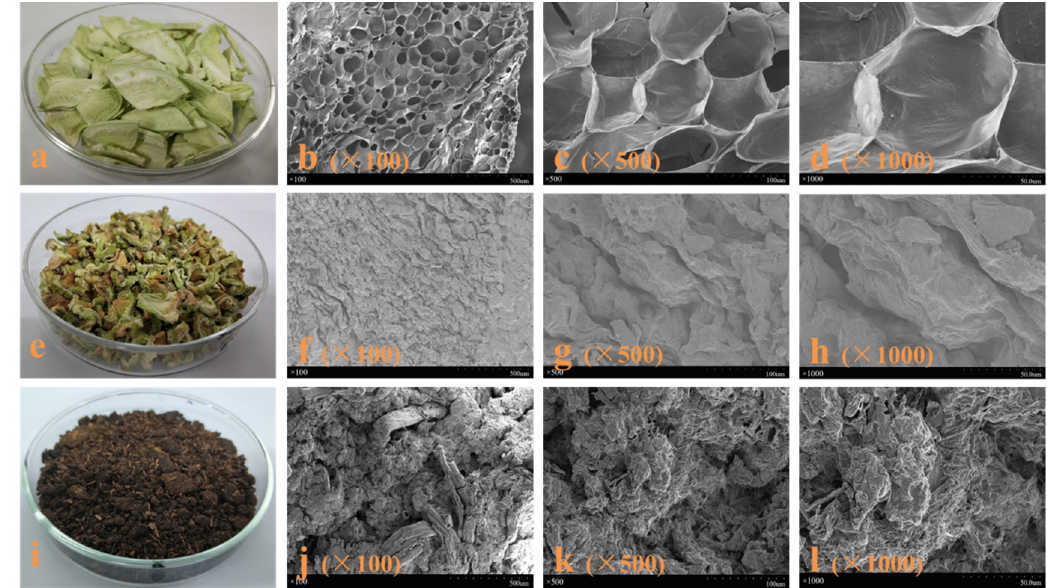
Figure 1. Optical and SEM images of freeze-dried broccoli sample ( a – d ), oven-dried broccoli sample ( e – h ), and SE broccoli sample at 204 °C for 10 min ( i – l ). Table 1. Chemical composition (g/100 g dry weight) of raw broccoli and SE